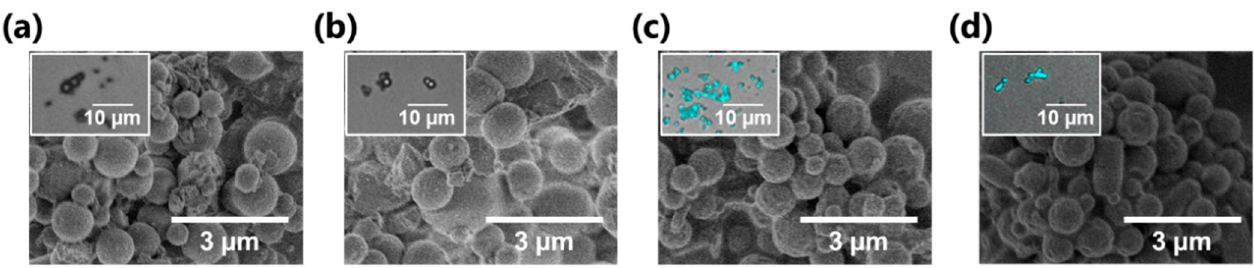
Figure 7. SEM and CLSM images (inset) of ( a , b ) DHP MPs and ( c , d ) TOCNF–DHP MPs (TOCNF, 0.5% ( w/v )) after loading with ( a , c ) methylene blue (MB) and ( b , d ) arginine (Arg). CLSM images were obtained after Calcofluor white staining. Each inset is a merged picture of bright field and fluorescent images obtained by CLSM.